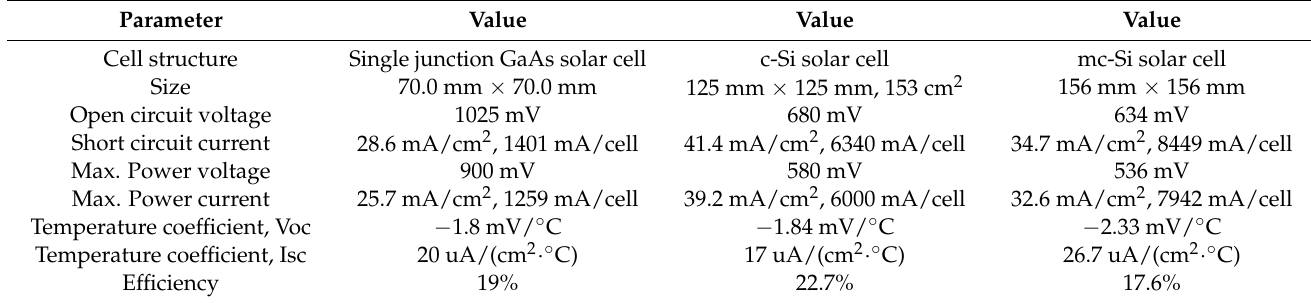
Table 4. Different types of solar cell parameters.